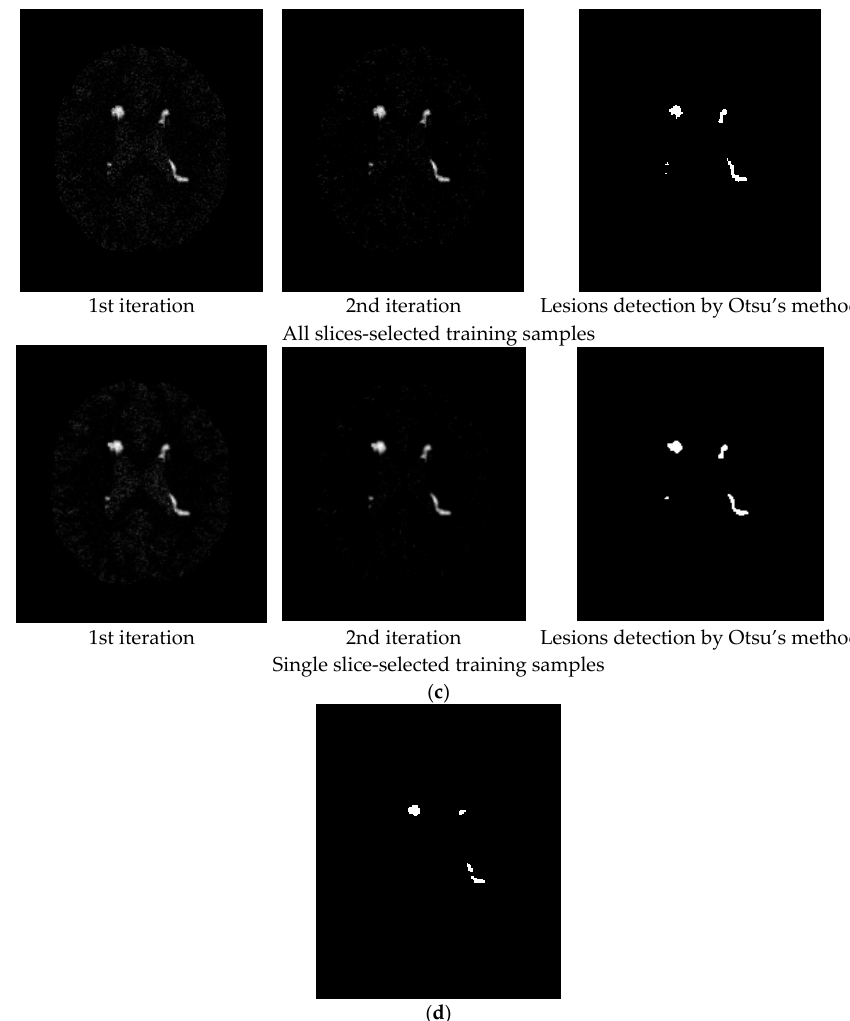
Figure 7. Lesion detection of Slice 97 with 3% noise and 0% INU by CBEP-ICEM1 and CBEP-ICEM2. ( a ) Original 97th slice of MS MR brain images with 3% noise and 0% INU; ( b ) CBEP-ICEM1; ( c ) CBEP-ICEM2; ( d ) Lesion detection LST.